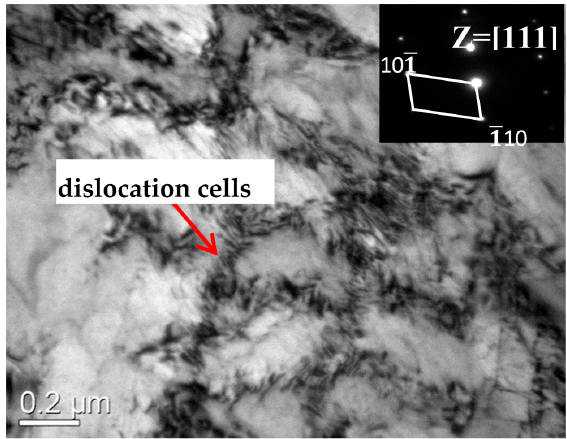
Figure 6. The dislocation cells in ferrite of 2707 HDSS deformed at 1050 °C and 0.01 s − 1 .